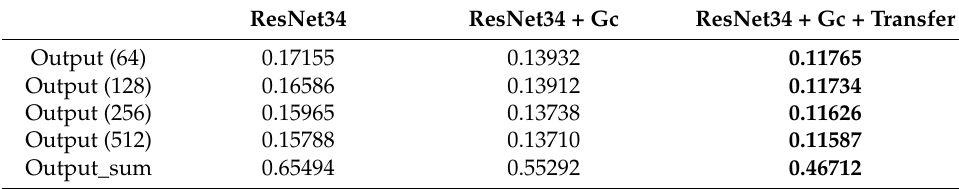
Table 3. Loss values at different scales, where the values in bold are the best.